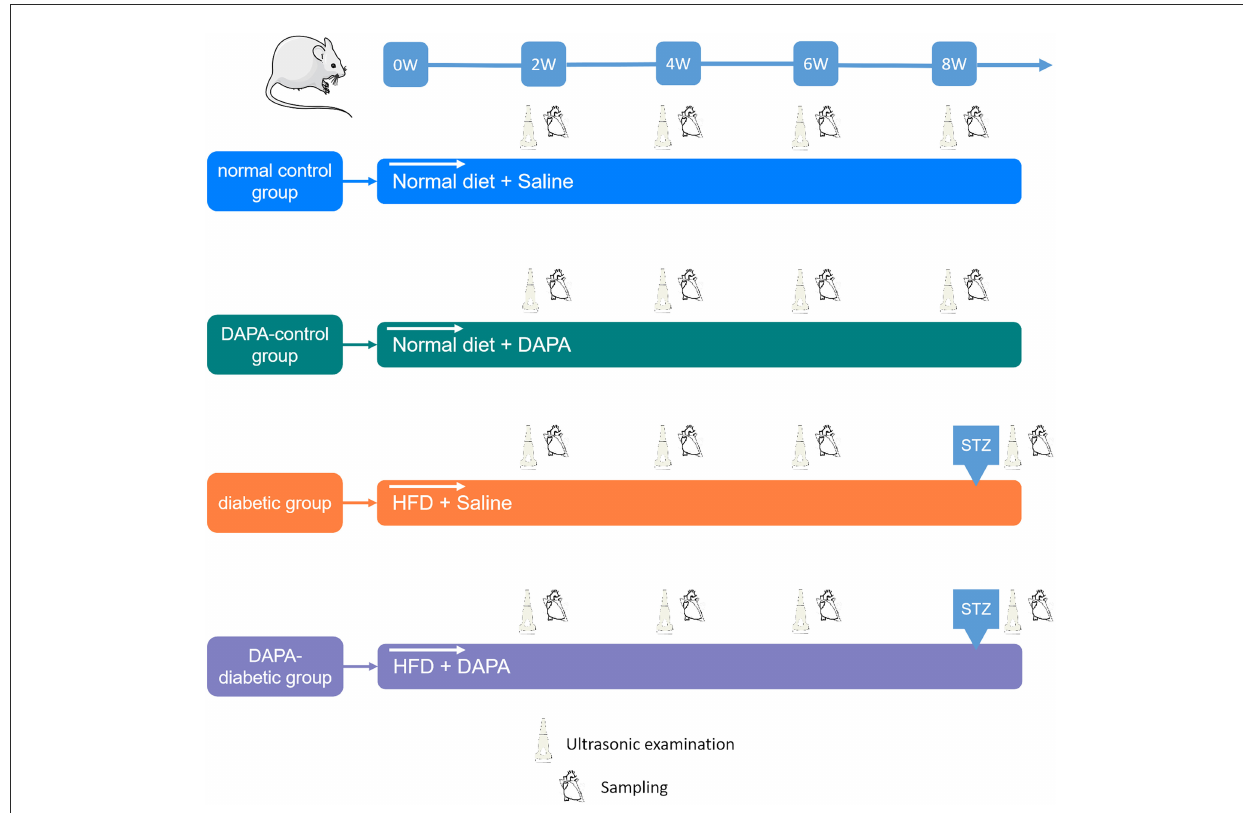
FIGURE1 Study design. For each group, echo-Doppler, 2D-STE, and MCE were performed every 2 weeks. The myocardium was collected at sacrifice for histopathological analysis.